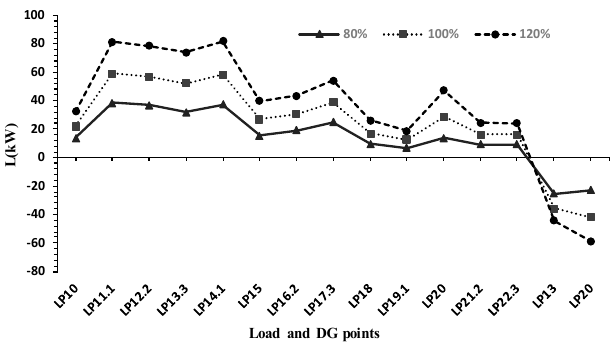
Figure 8. Allocated losses for three different levels of load and generation.